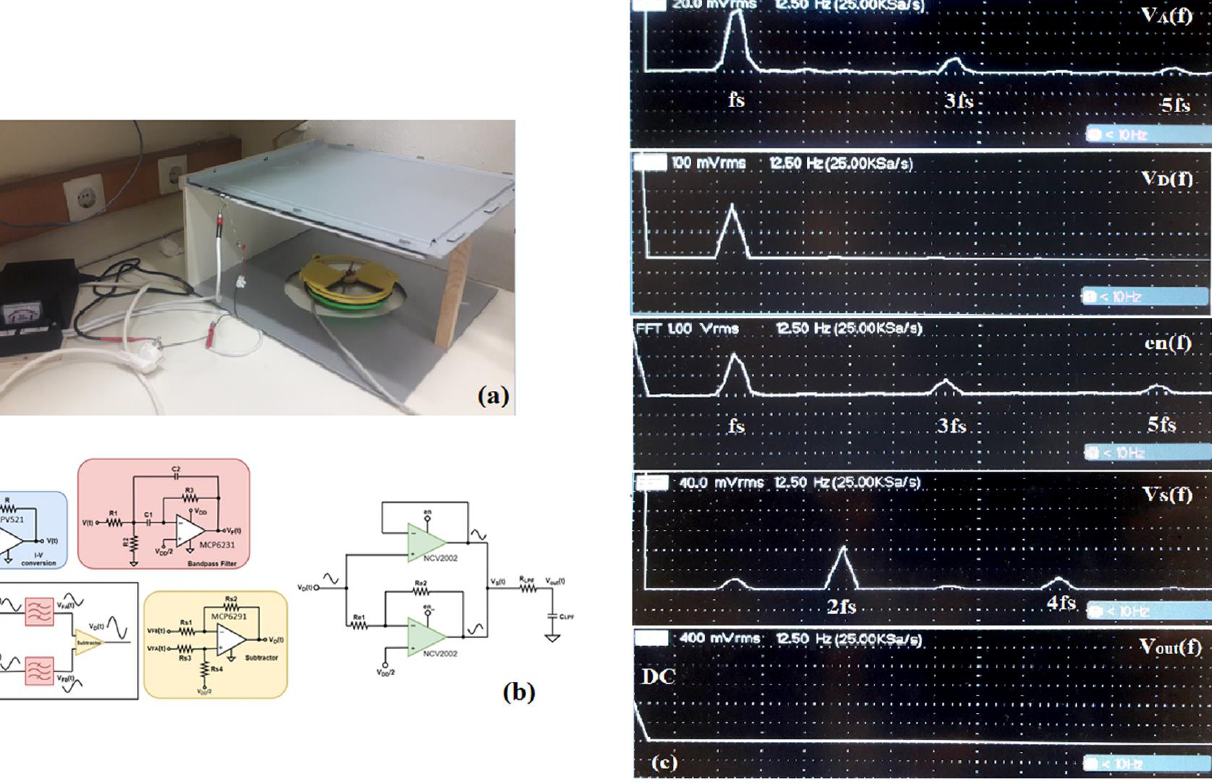
Figure 4 . ( a ) 3D-printed field mill and calibration setup ( b ) Schematic of the discrete implementation of interface circuitry ( c ) FFT of signals . of interface circuitry ( c ) FFT of